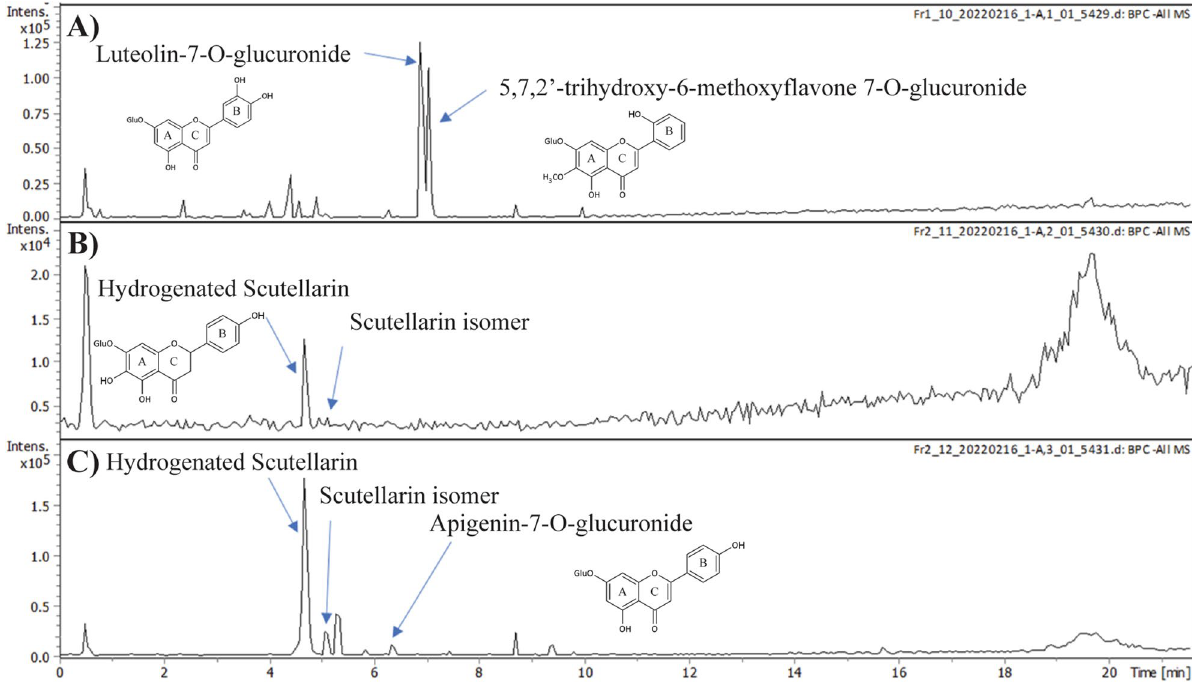
Figure 5. LC–MS/MS identification of the unknown peaks in the HPLC fractions ( A ) S. arenicola unknown fraction 1–10 with two identified metabolites and their chemical structures. S. baicalensis unknown fractions ( B ) 2–11 and ( C ) 2–12 showing identified metabolites and their chemical structures. Please refer to Supplemental Fig. S4-S6 for detailed MS1 and MS2 spectra supporting the level 2 identification of the